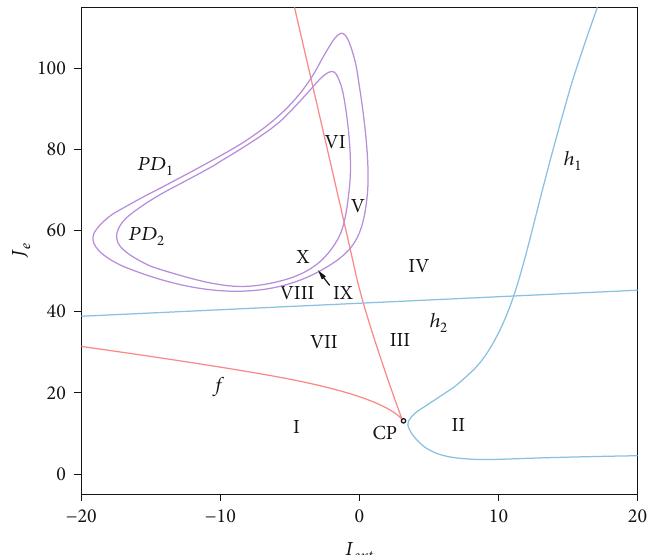
, h : Hopf bifurcation curve (blue); 1 2